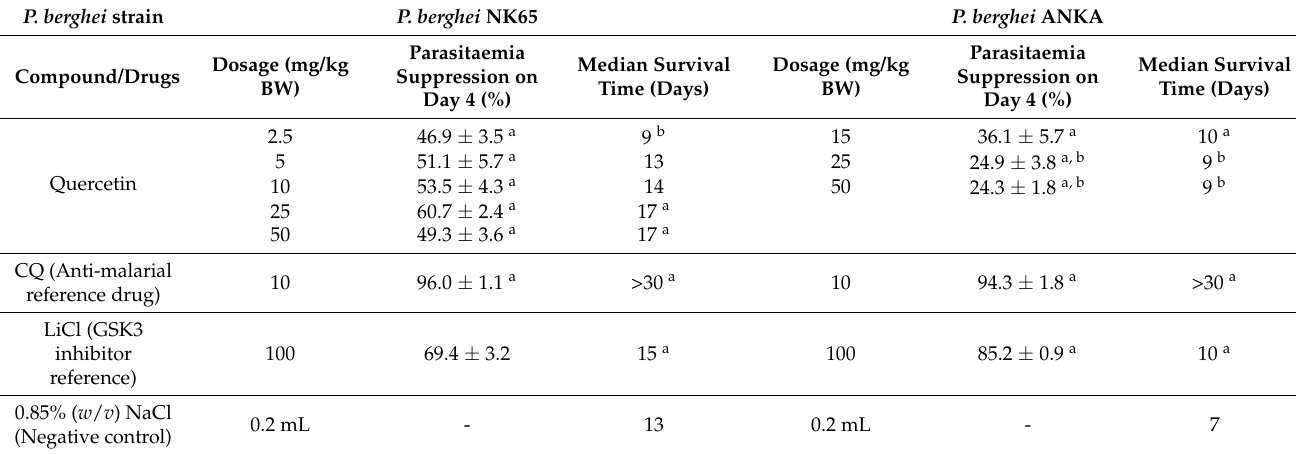
Data represent mean ± SD for parasitaemia suppression and median survival time ( n = 7). a represents values significantly different from negative control ( p < 0.05), b represents value which significantly different from CQ ( p < 0.05).